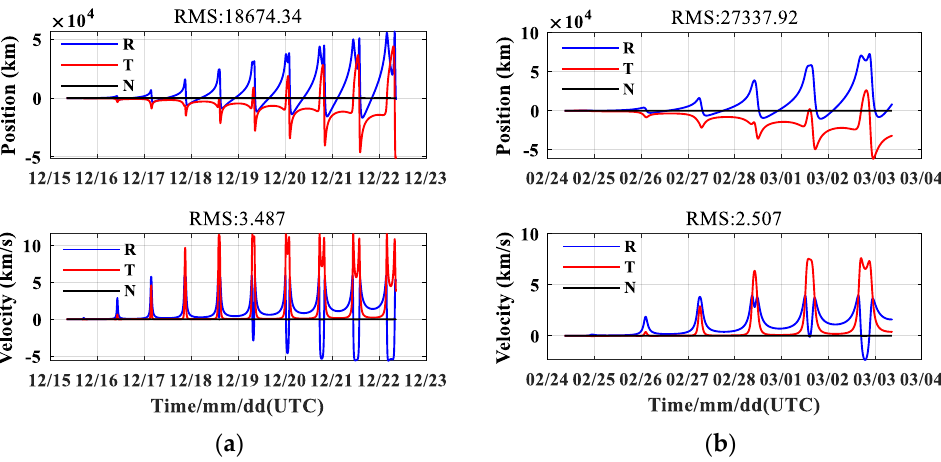
Figure 8. Electrical thrust effect. ( a ) Electrical thrust effect of phase 1. ( b ) Electrical thrust effect of phase 2.